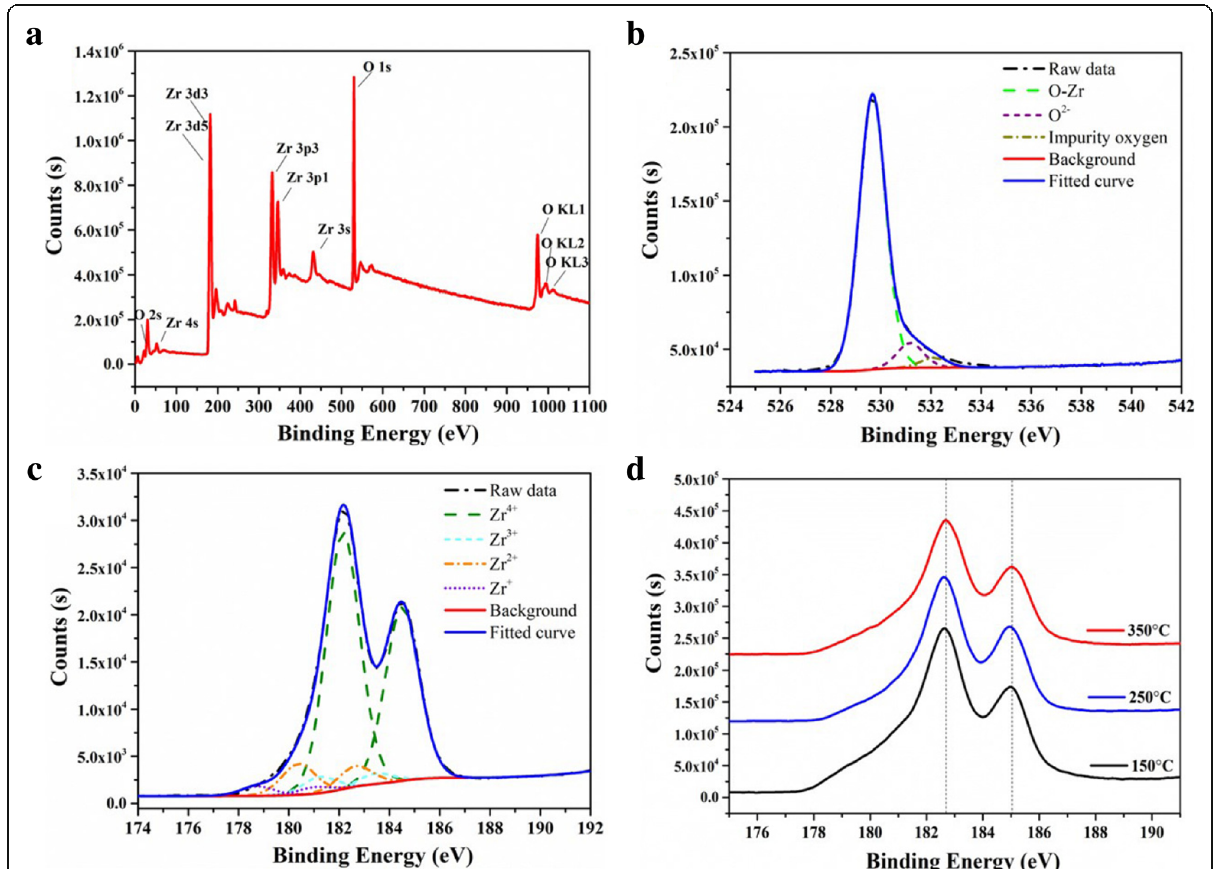
Fig. 5 The full spectrum scan of XPS ( a ), the fine spectra of O 1 s ( b ), and Zr 3d ( c ) for ZrO 2 film deposited on Si(100) at 250 °C, and the fine spectra of Zr 3d for ZrO 2 films deposited at 150, 250, and 350 °C ( d